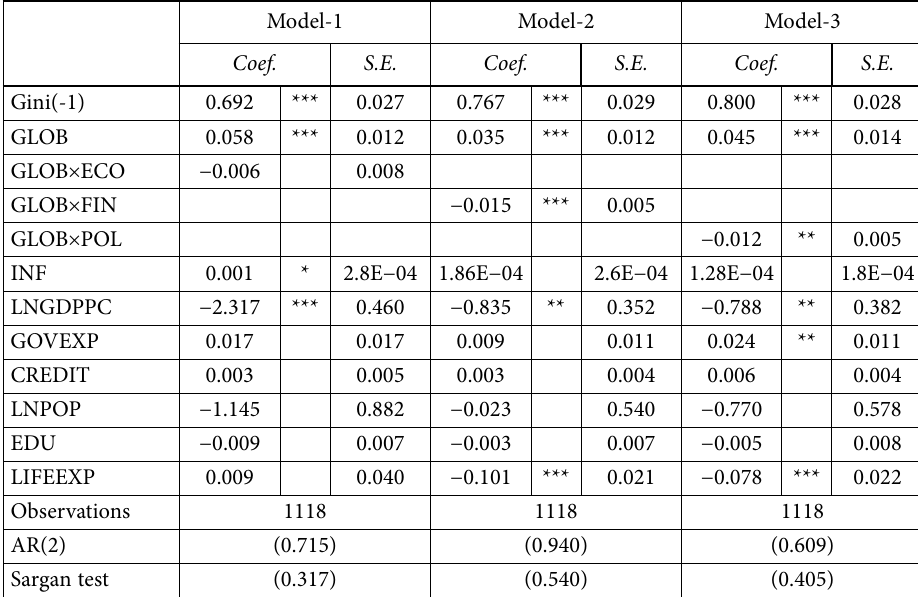
Table 12. Inequality, globalization, and country risk (non-OECD